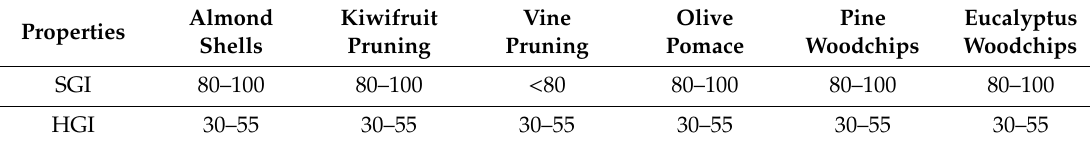
Table 5. Grindability indices calculated for the di ff erent biomass waste